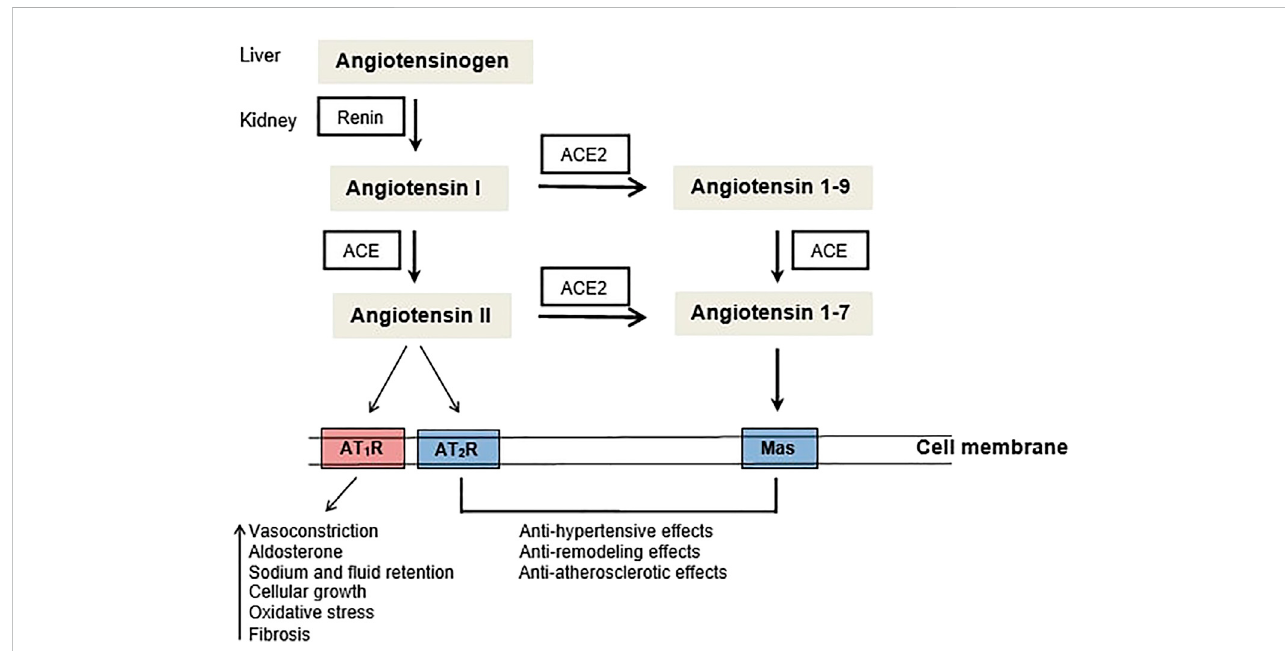
FIGURE 1 The renin-angiotensin system (RAS): ACE - angiotensin converting enzyme, AT1R - Angiotensin II type 1 receptor, AT2R - Angiotensin II type 2 receptor.